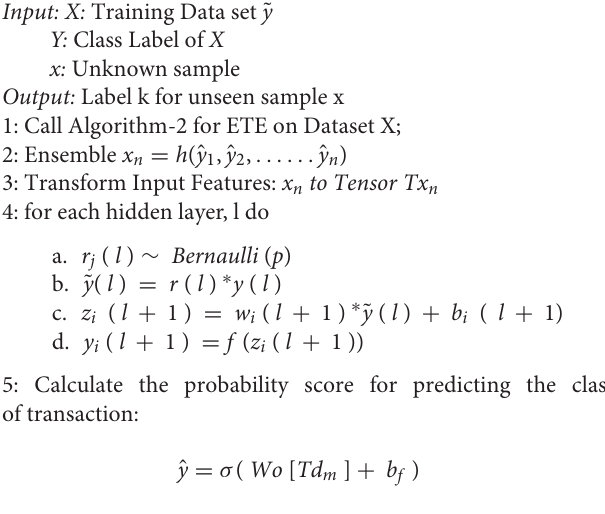
Algorithm 1| Extra Tree Ensemble Optimized DL Algorithm